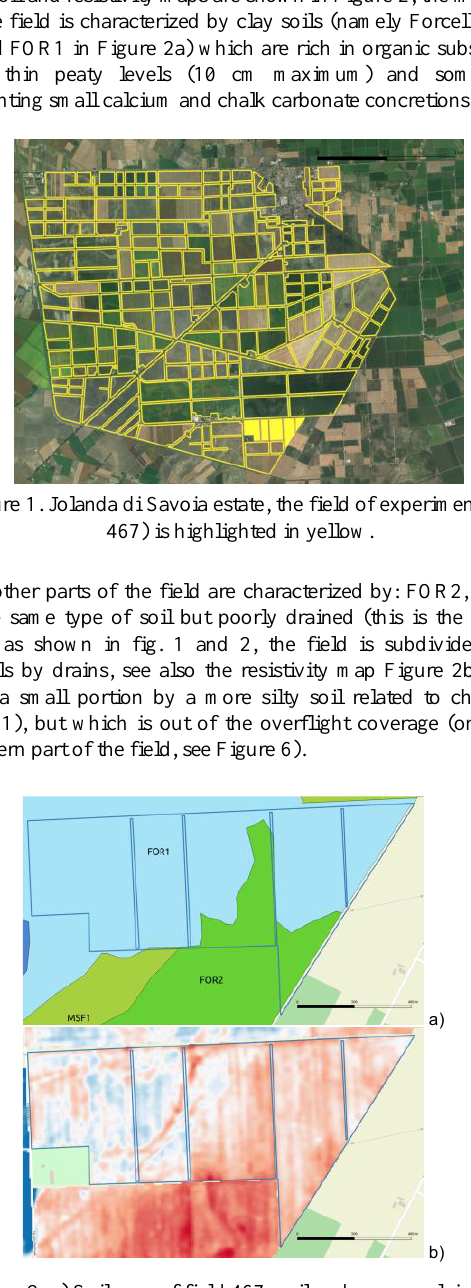
Figure 2. a) Soil map of field 467: soil codes are explained in the text. b) Resistivity map of field 467; it is visible, more in detail as respect to the soil map, the poorly drainage soil conditions (low resistivity depicted in